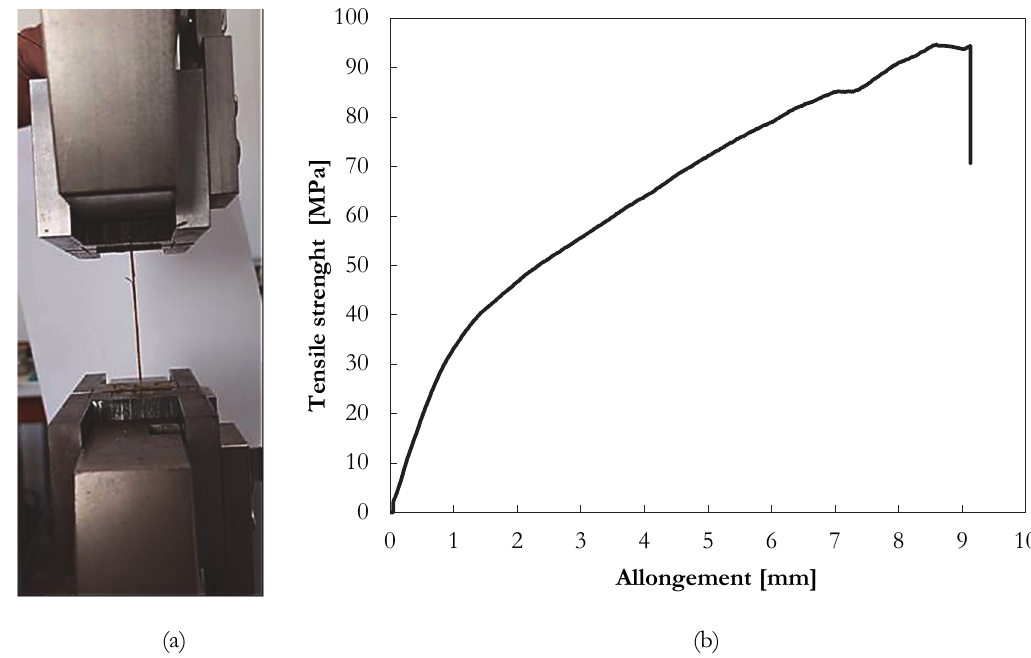
Figure 6: The direct tensile test on date palm fiber mesh: (a) loading device and (b) tensile